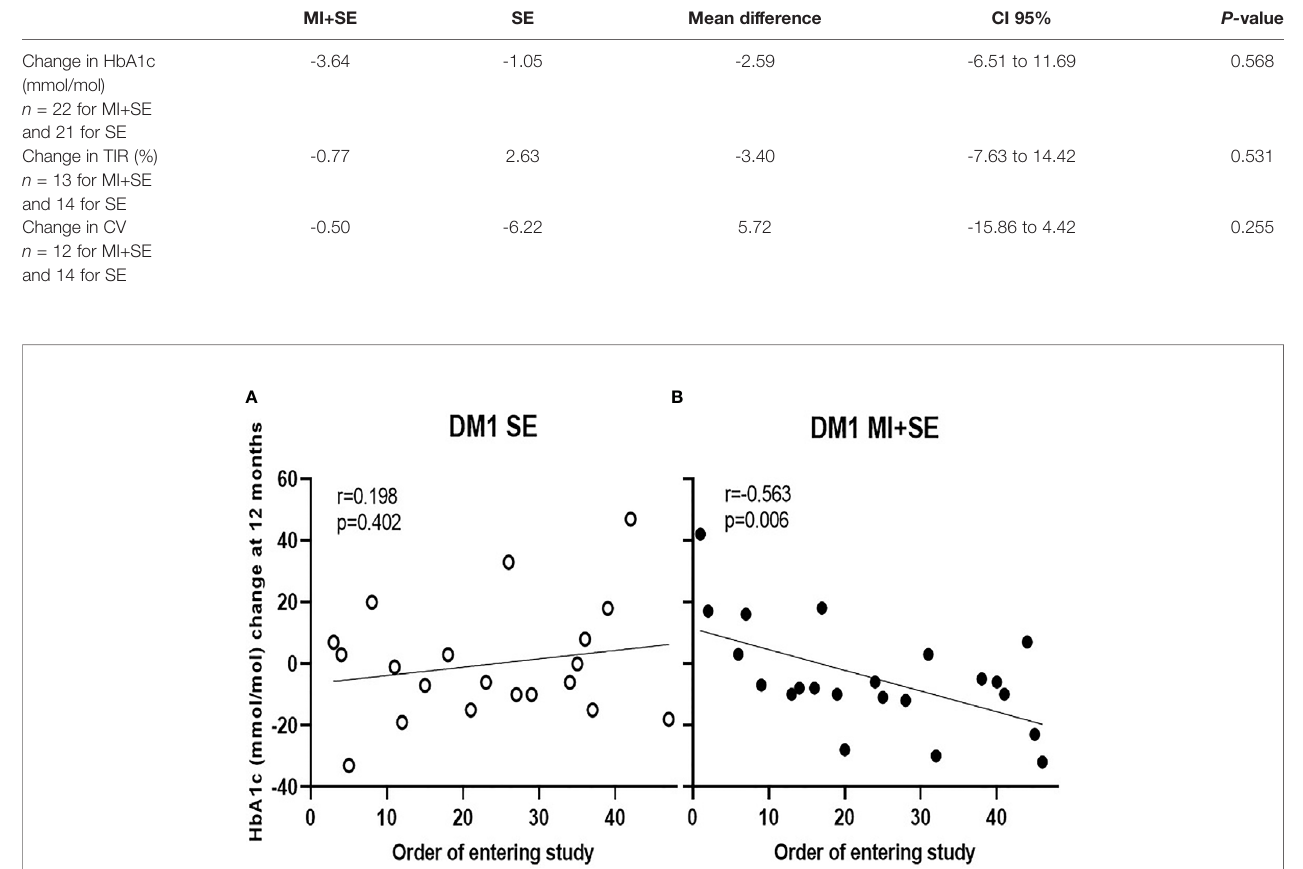
FIGURE 4 | Correlation between the order of joining the study and the 12-month change in HbA1c for the MI+SE (B) and the SE-only group (A) . Patient 1 was the fi rst patient recruited for the study, and patient 47 was the